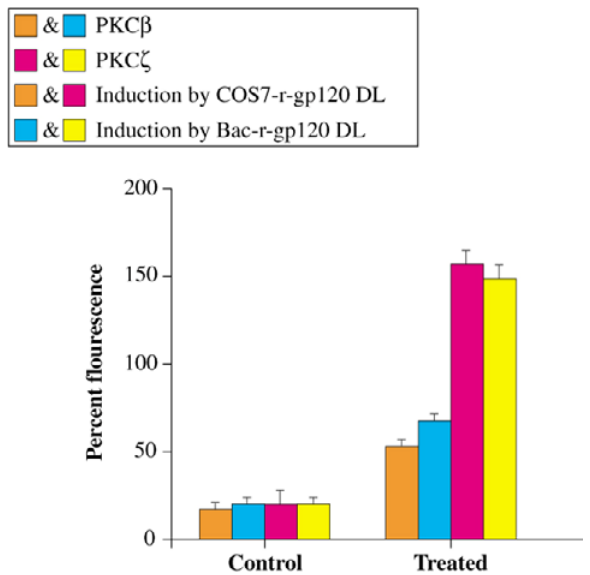
Figure 5. Effect of stimulation of astrocytes with recombinant mutant gp120 on PKC. PMA or recombinant mutant gp120 produced from COS-7 cells (COS7-r-gp120DL) or by insect cell/baculovirus system (Bac-r-gp120DL) was applied to rat astrocytes. PKC isozyme activity is presented as a percentage of the activity induced by PMA. Each bar represents a mean of five assays. Both protein preparations stimulated PKC to a similar level. PKC ζ response was significantly (P<0.05) higher than that of PKC β